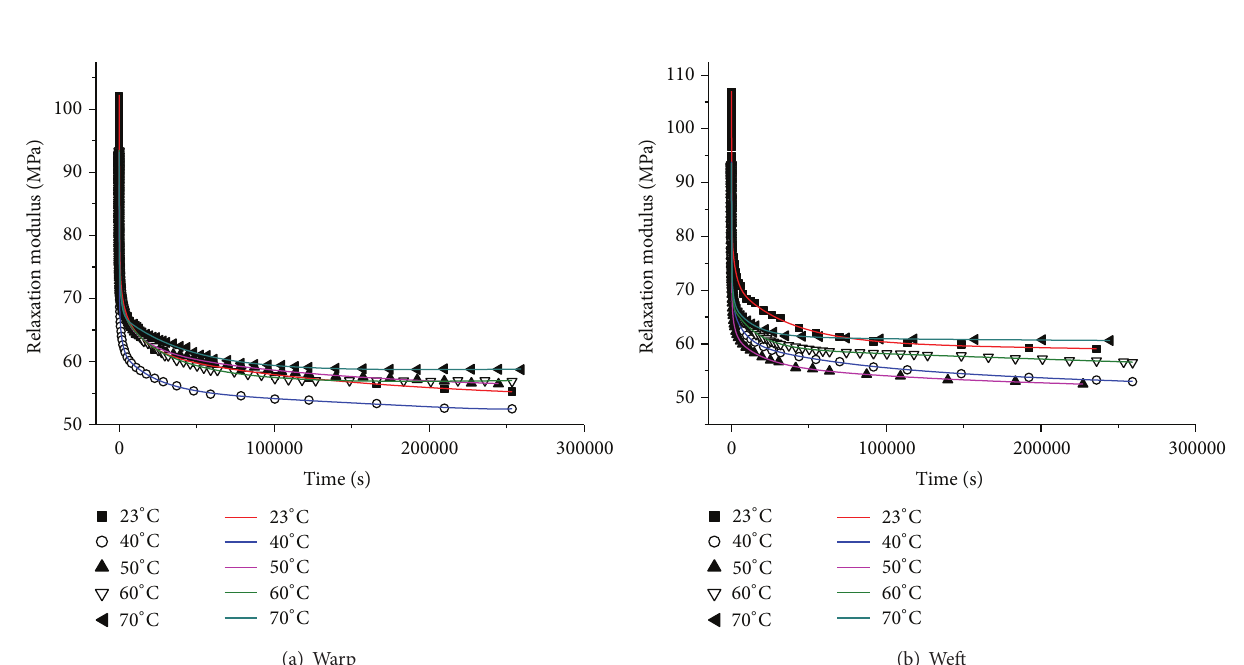
Figure 10: Predictions of the generalized Maxwell model (five-component model).